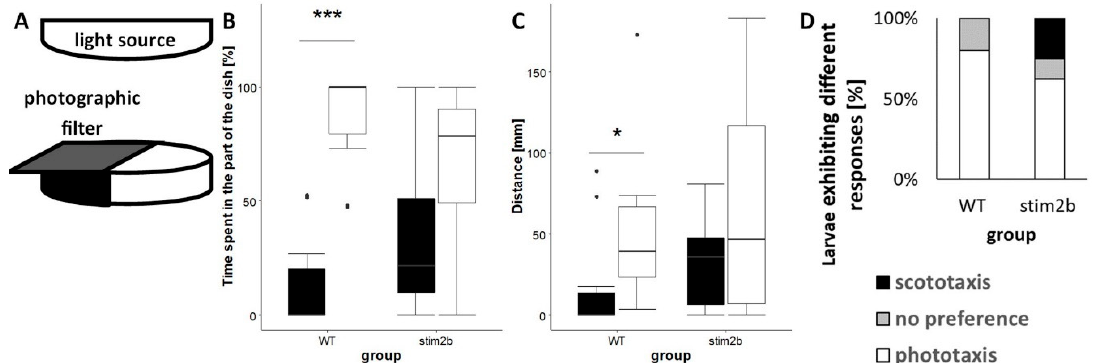
Figure 4. Disruption of phototaxis in stim2b − / − larvae in the light preference test. ( A ) Schematic diagram of the experimental design. The Petri dish was exposed to white light that emanated from above the dish. Illumination of half of the area of the dish was limited using a gray photographic filter. ( B , C ) Boxplots of the time spent and distance traveled in each part of the dish (black in the dark part, white in the light part) in WT and stim2b − / − larvae. * p < 0.05, ** p < 0.01, *** p < 0.001, dark vs. light part for each genotype (paired t -test). ( D ) Stacked bar chart of the distribution of different types of responses: phototaxis (> 70% time in the light part), no preference (30-70% time in the light part), and scototaxis (< 30% time in the light part). The distribution of responses was compared using Pearson’s χ 2 test ( p = 0.2419). Number of larvae: n = 10 WT, n = 8 stim2b − / − . Number of experiments: 5.